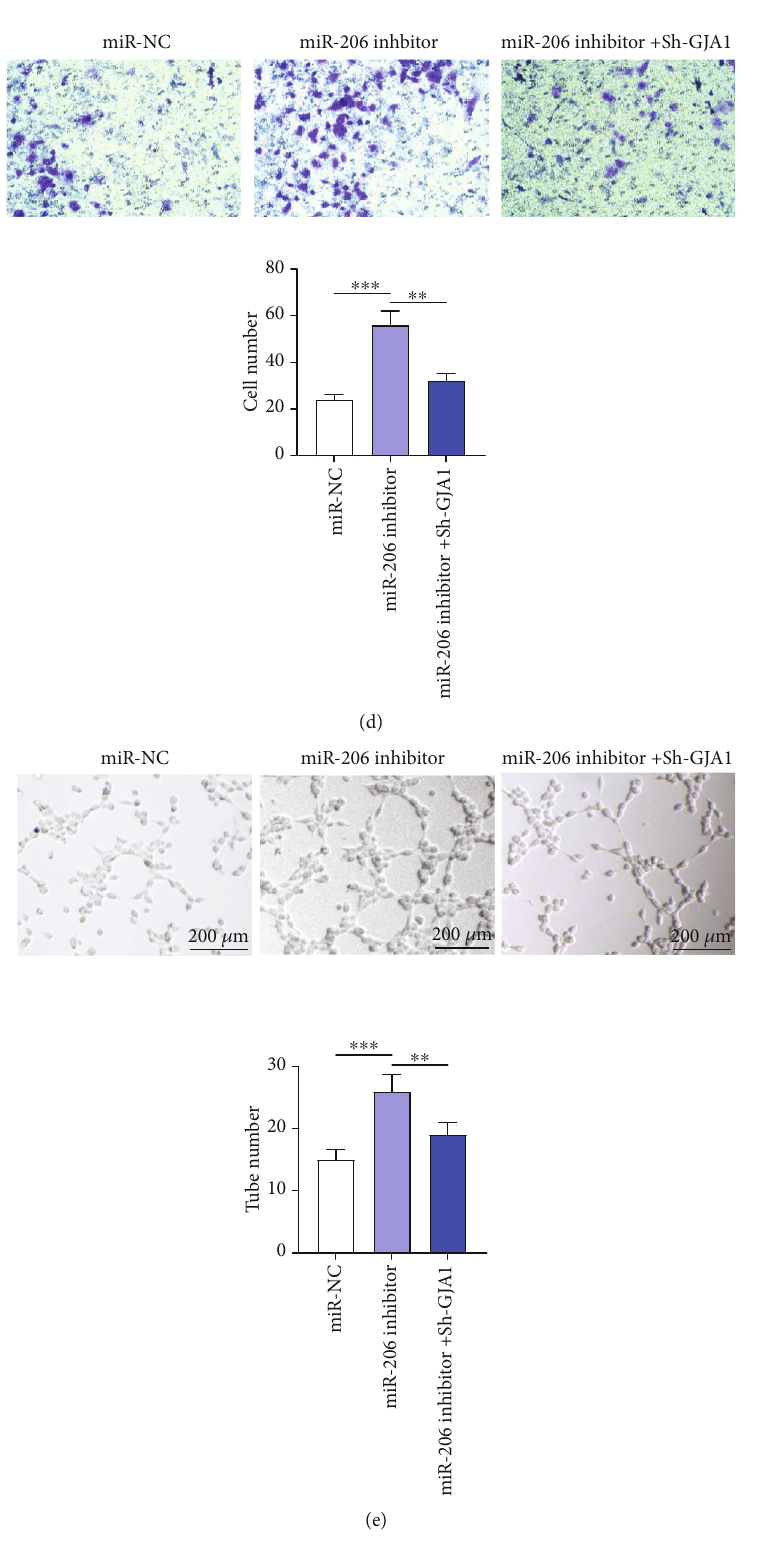
Figure 3: GJA1 silencing attenuates the in fl uence of miR-206 downregulation on EPC proliferation, apoptosis, migration, and angiogenesis. (a) Western blotting analysis of GJA1 protein level in EPCs after GJA1 silencing. (b) CCK-8 assay of EPC proliferation at 0, 24, 48, 72, and 96h after miR-NC, miR-206 inhibitor, or miR-206 inhibitor+sh-GJA1 transfection. (c) Flow cytometry analysis of the apoptosis of EPCs after the above transfection. (d) Transwell migration assay of cell migration at 24h after the above transfection. (e) In vitro tube formation assay of EPC angiogenesis after the above transfection. Representative images of capillary tube formation and the number of tubes are shown. ∗ p < 0 : 05 , ∗∗ p < 0 : 01 , and ∗∗∗ p < 0 : 001